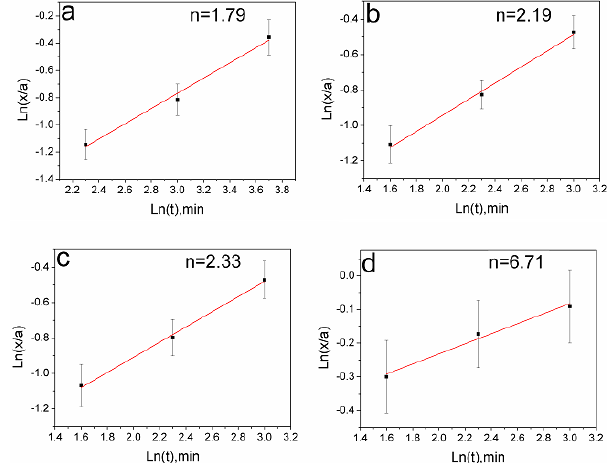
Figure 4. The ln( x / a ) ‐ ln( t ) curves of sintering joints with a fiber angle of 90° during isothermal holding at ( a ) 1000 °C; ( b ) 1100 °C; ( c ) 1200 °C ( n = 2.33); and ( d ) 1200 °C ( n = 6.71).